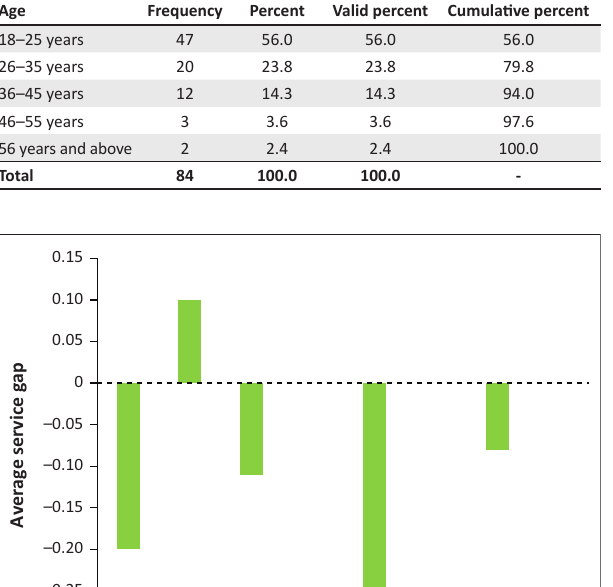
TABLE 1: Age group frequency of respondents.